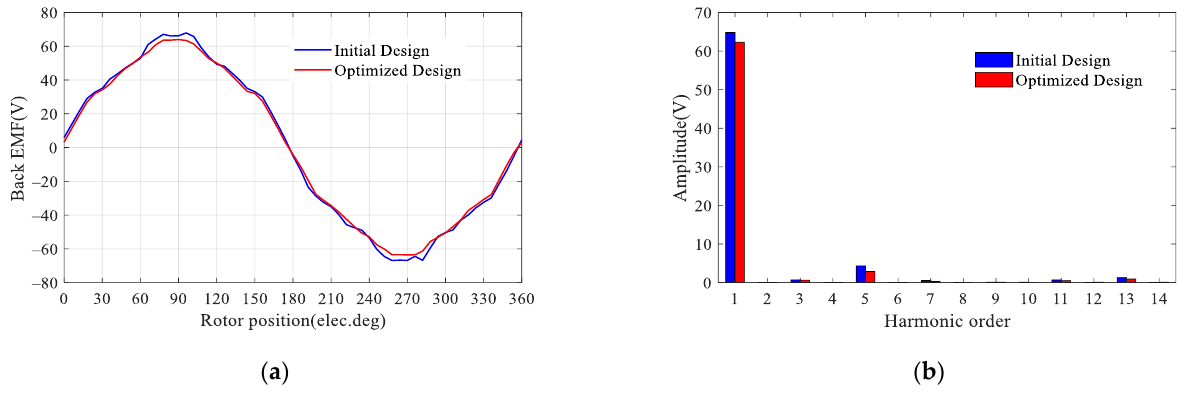
Figure 12. Open-circuit phase back EMF comparisons. ( a ) Waveform; ( b ) harmonic spectra.